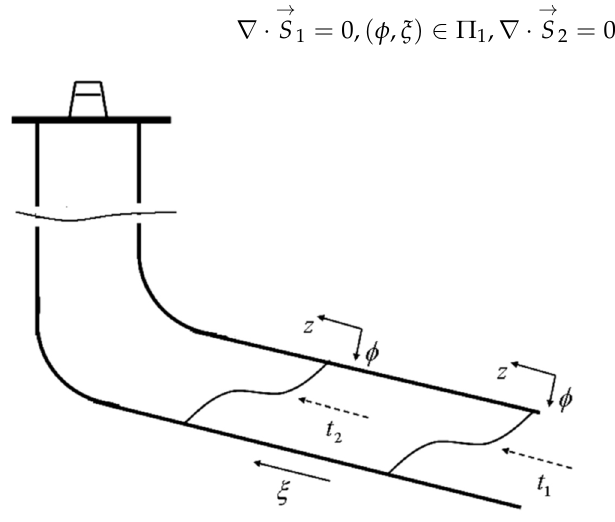
Figure 2. Foundation of the reference coordinate system.